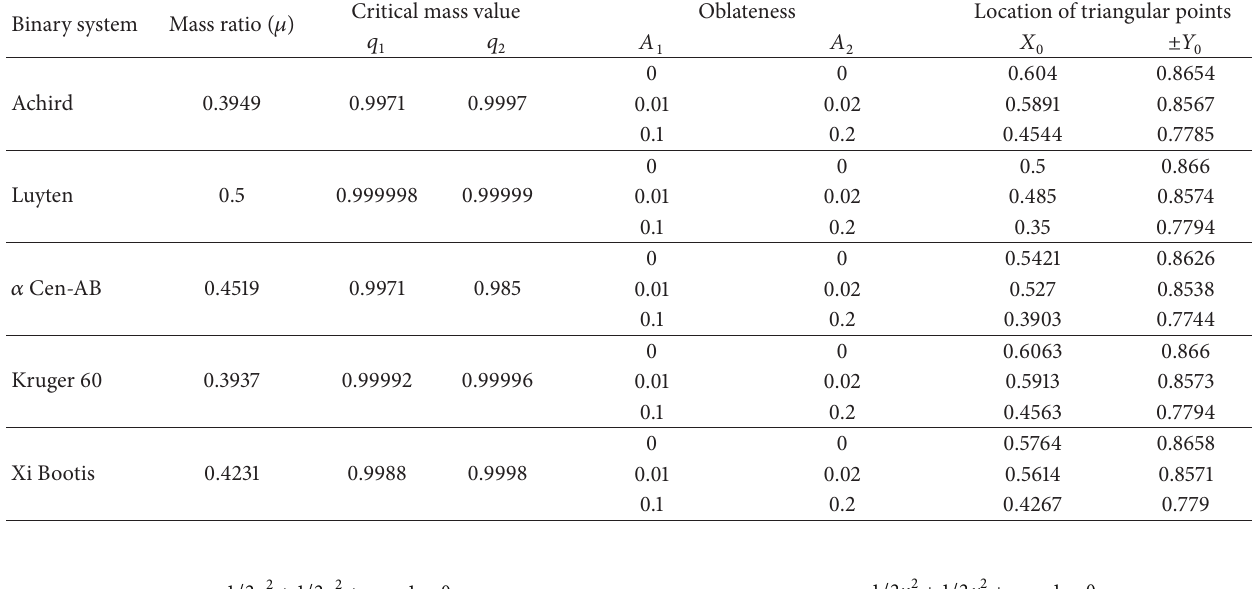
Table 1: Location of triangular equilibrium points mentioned in the research paper of Jagdish and Aishetu [30].